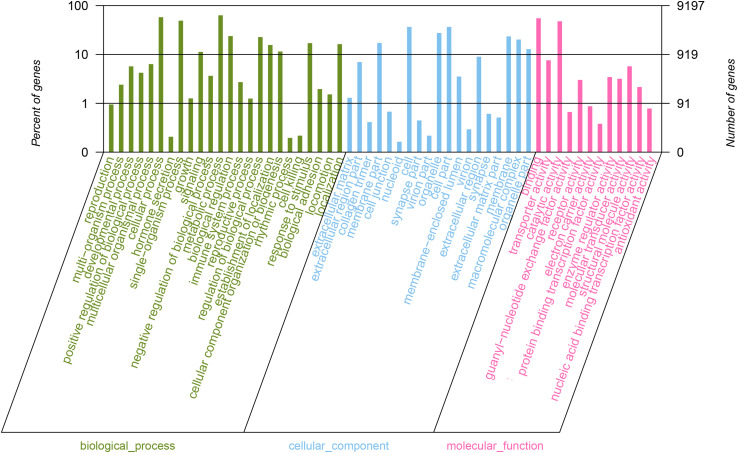
Functional annotation of all unigenes based on gene ontology (GO) categorization. GO analysis was performed at the level for three main categories (cellular component, molecular function, and biological process).